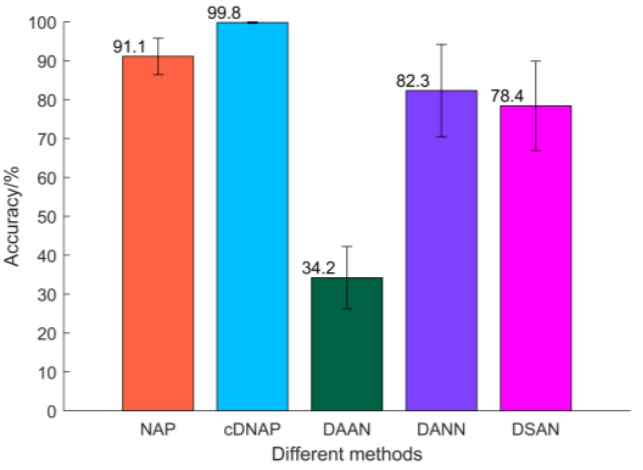
Figure 12. Average accuracy of different